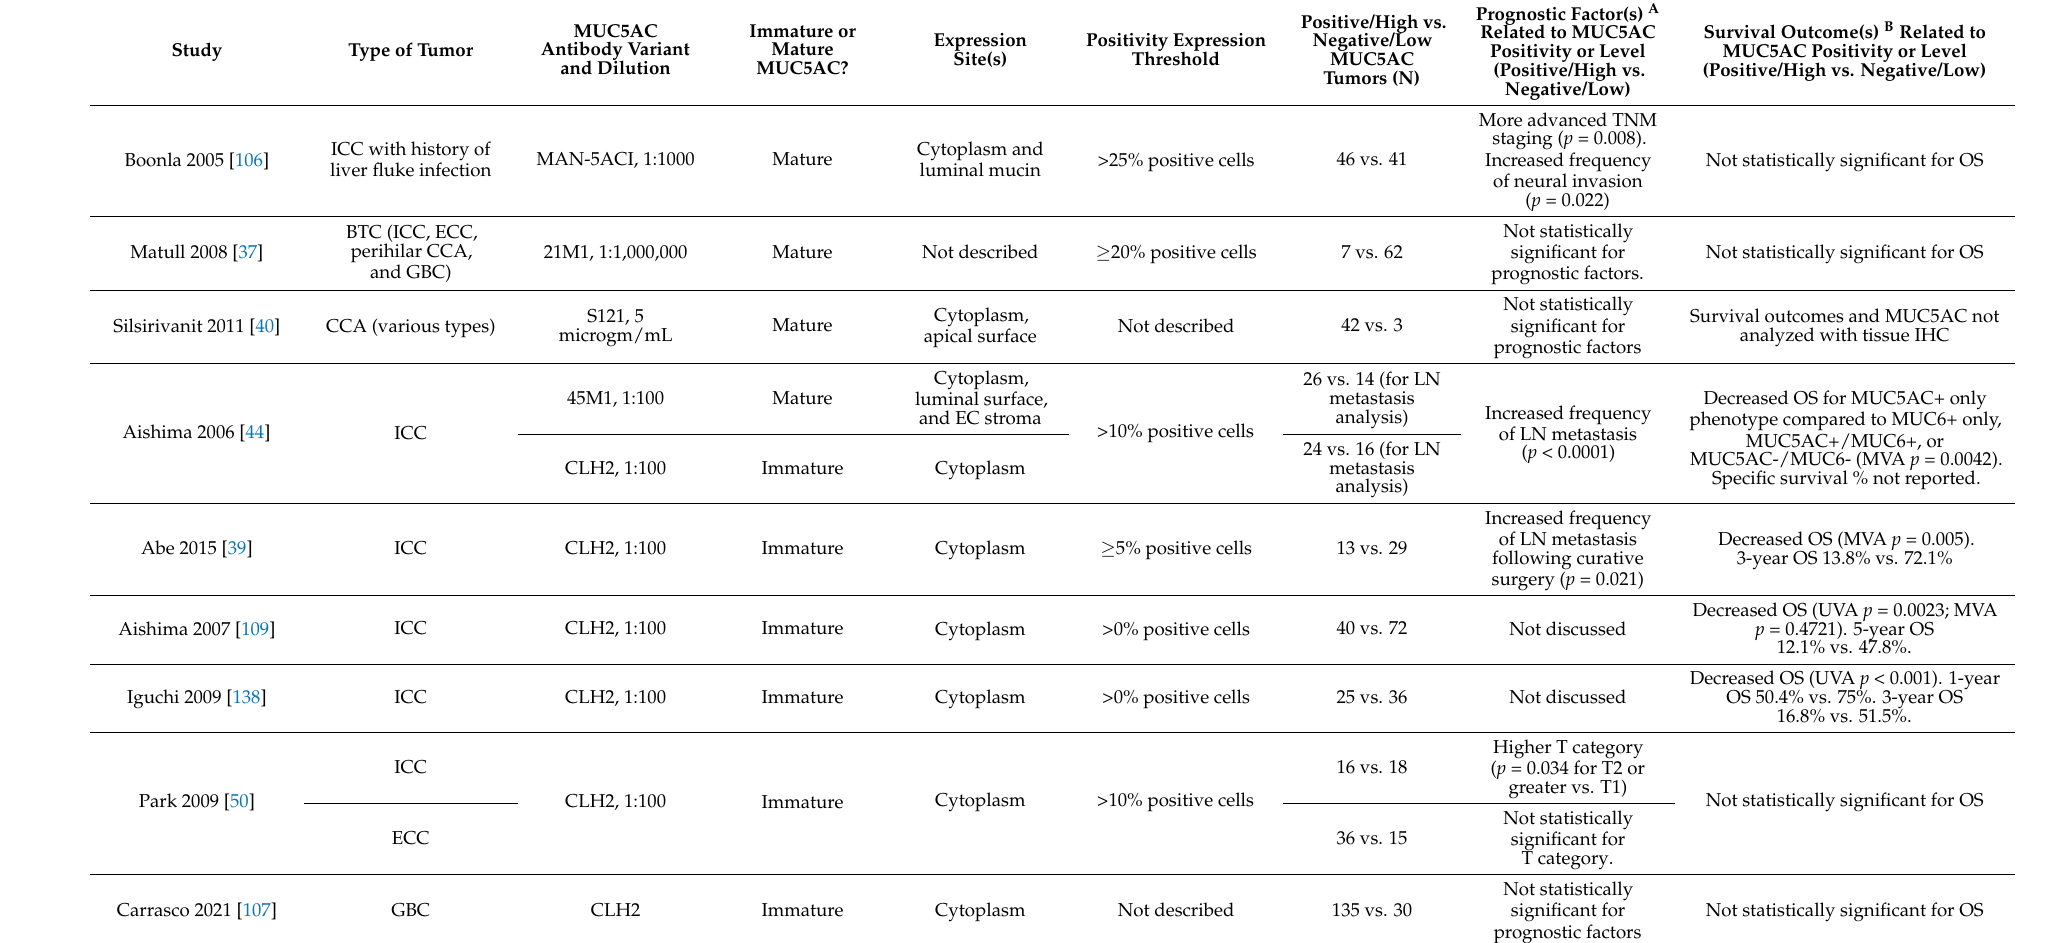
Table 4. Studies evaluating the prognostic impact of MUC5AC expression in BTC (tissue